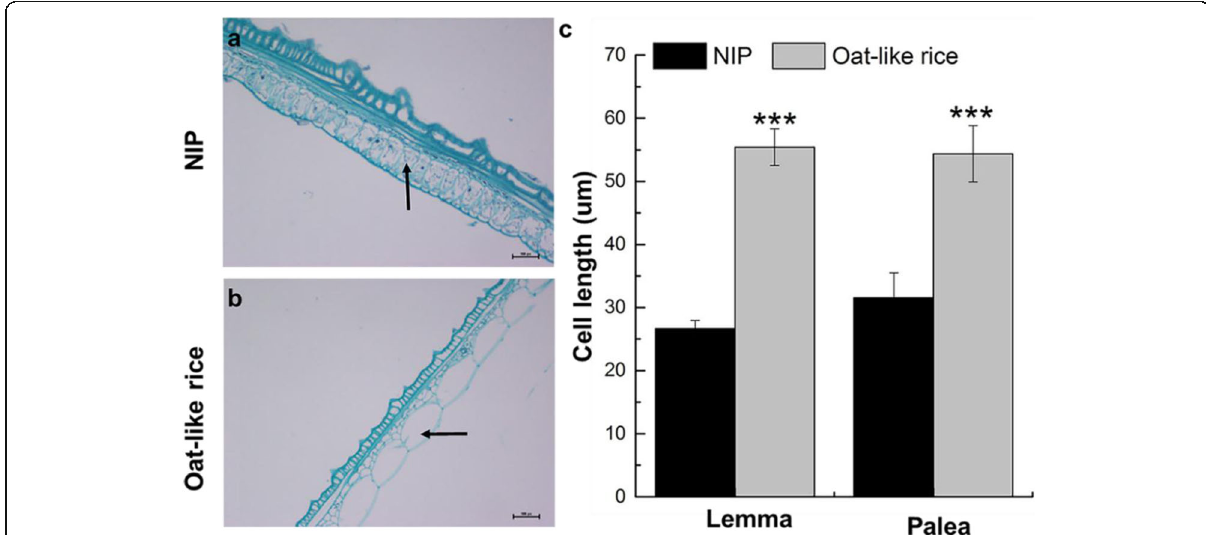
Fig. 2 Histocytological analysis of spikelets hulls in NIP and Oat-like rice. a and b longitudinal sections at the middle of lemma in spikelets of NIP ( a ) and Oat-like rice ( b ). c Comparisons of cell length between NIP and Oat-like rice in the longitudinal sections at the middle of lemmas and paleae in spikelets. Arrows in a and b indicate parenchyma cells used for statistical analysis of cell length in ( c ). Bars: ( a and b ) 200 μ m. Data presented are mean values± SDs [ n = 27 replicates in c.]. Student ’ s t-test: *** p <